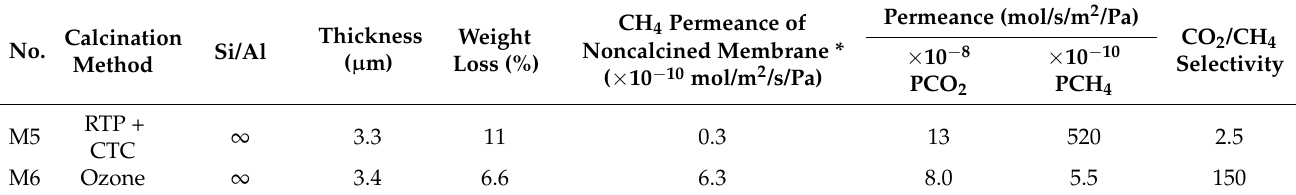
Table 3. Equimolar CO 2 /CH 4 mixture separation performances of all-silica ZSM-58 zeolite membranes under a total feed pressure of 1.1 MPa at room temperature.